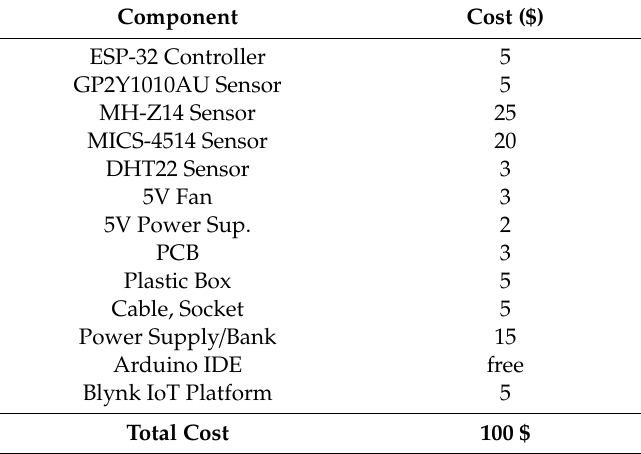
Table 2. Cost table for IoT-based e-nose measurement